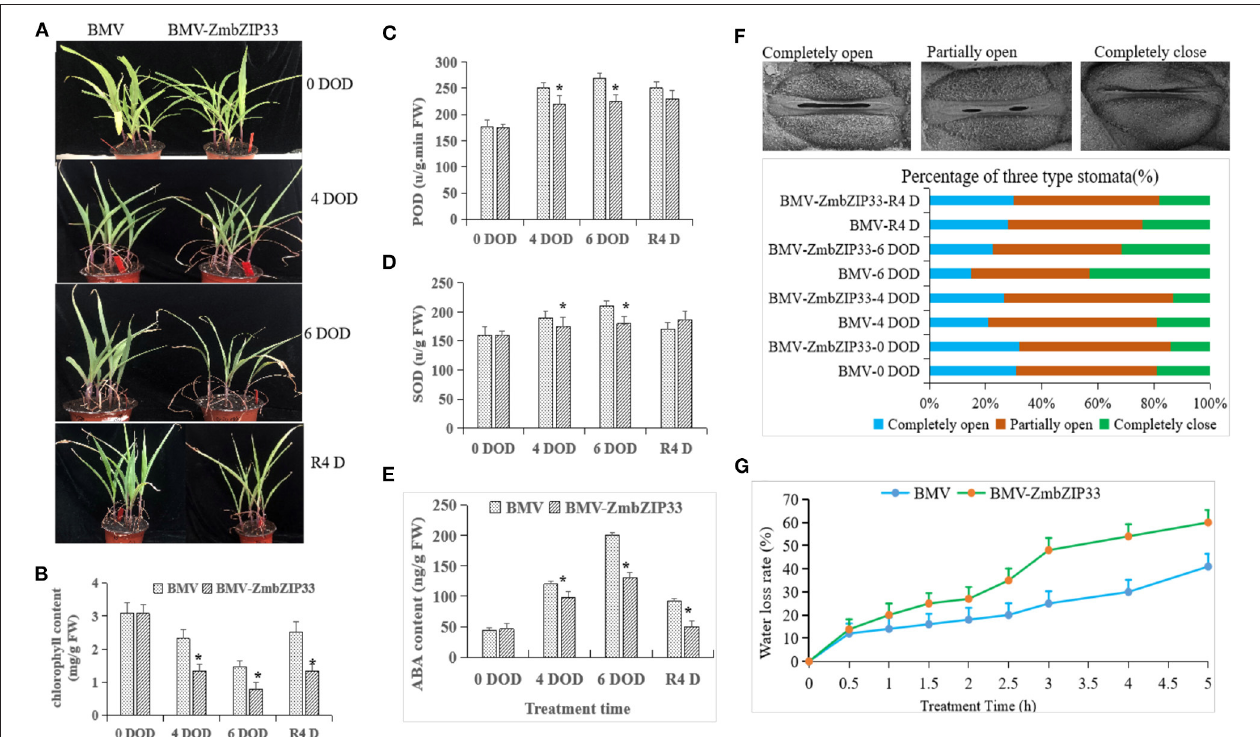
FIGURE 6 | Analysis of ABA sensitivity and drought resistance of ZmbZIP33 under drought stress. (A) Forty percent of PEG stress on BMV and BVM-ZmbZIP33 maize seedlings for 4 and 6 days (DOD). The plants were then rewatered for 4 days (R4 D) and photographed. (B–E) Chlorophyll content, SOD activity, POD activity, and ABA content of BMV and BVM-ZmbZIP33 leaves were measured under drought stress and rewatering. (F) Scanning electron microscopy images of three levels of stomatal opening in BMV and BMV-ZmbZIP33. Bar = 20 µ m. (G) Water loss assays for the leaves of BMV and BMV-ZmbZIP33 transgenic line were performed within 5h. Mean values and standard errors (bar) were shown from five independent experiments. Independent t -tests for equality of means demonstrated that there was significant difference between control and treatment (* P value <